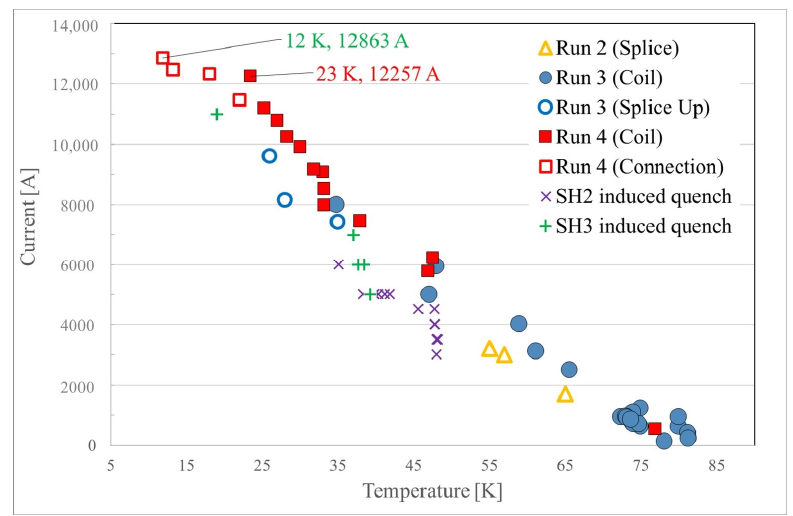
Figure 23. Results (maximum current vs. operating temperature) of the power test of FeatherM0 at CERN. The run numbering is accompanied by an indication of where the quench happened spontaneously (coil or splice). SH are heaters for the induced quench. Courtesy of J. van Nugteren and H. Bajas